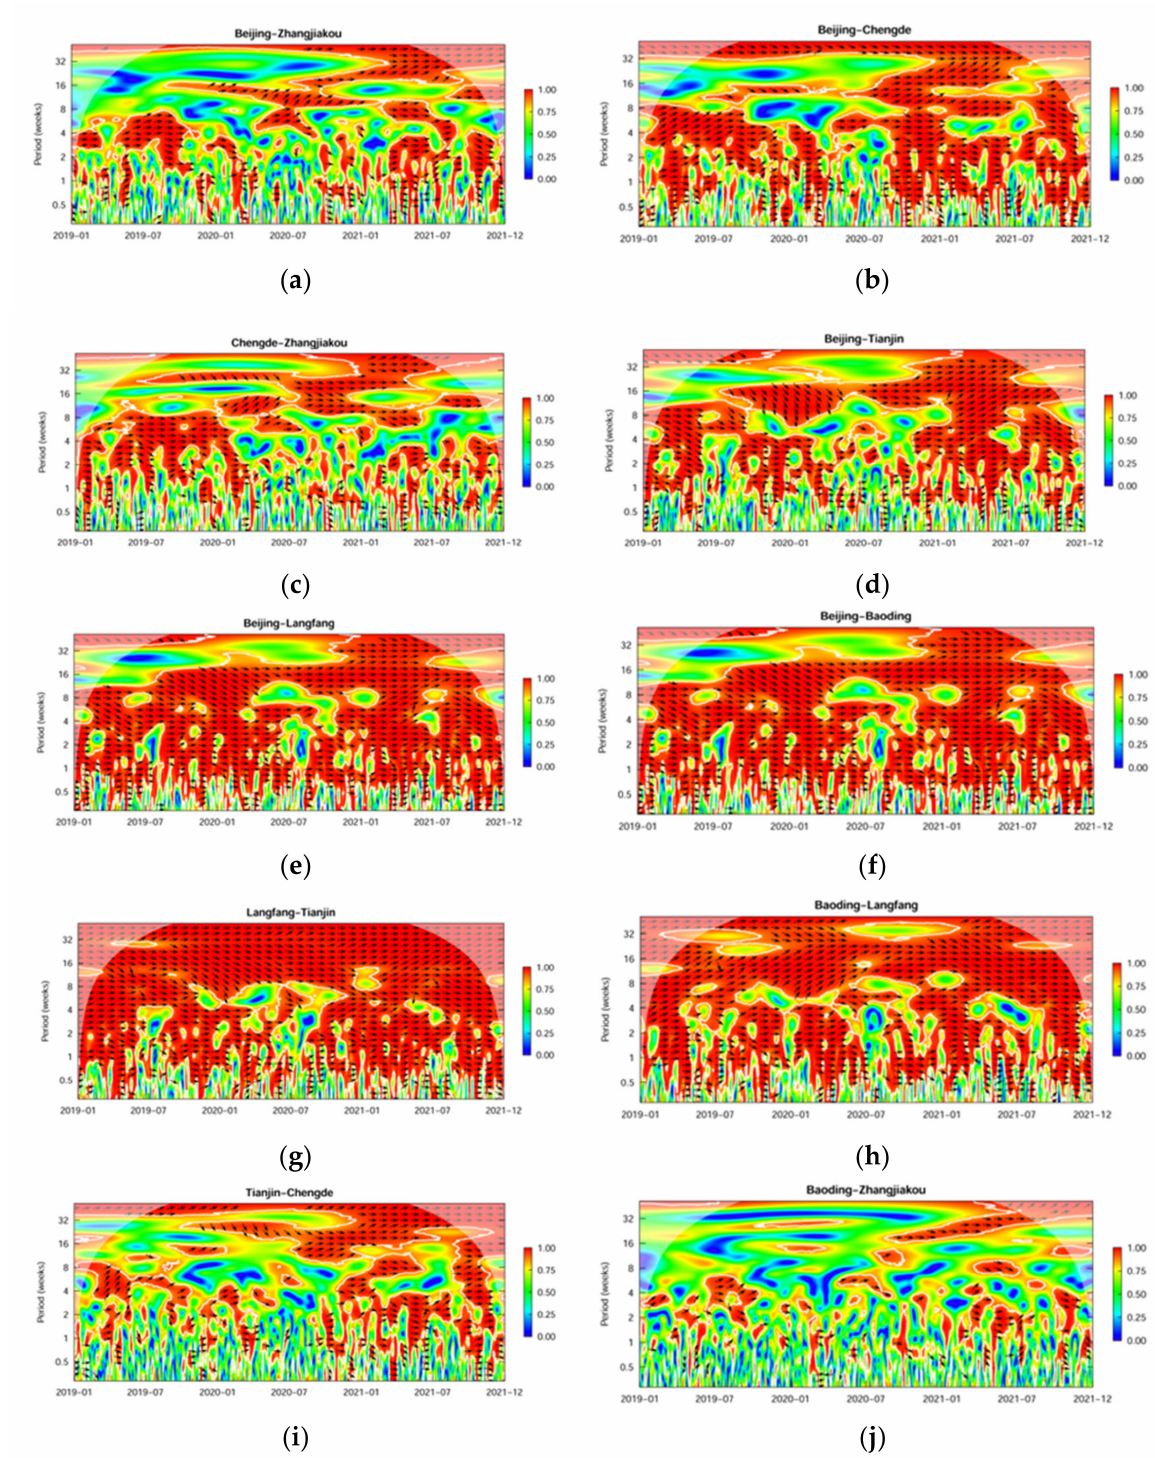
Figure 5. Periodic conformance test results of AQI variations in Beijing and its neighboring cities. Note: Wavelet coherency ranges from blue (low coherency) to red (high coherency). The white shade contour designates the cone of influence, which indicates the region affected by edge effects. The white contour inside the white shade contour marks the 5% significance level estimated from Monte Carlo simulations. ( a ) Beijing–Zhangjiakou. ( b ) Beijing–Chengde. ( c ) Chengde–Zhangjiakou. ( d ) Beijing–Tianjin. ( e ) Beijing–Langfang. ( f ) Beijing–Baoding. ( g ) Langfang–Tiannjin. ( h ) Baoding– Langfang. ( i ) Tianjin–Chengde. ( j )